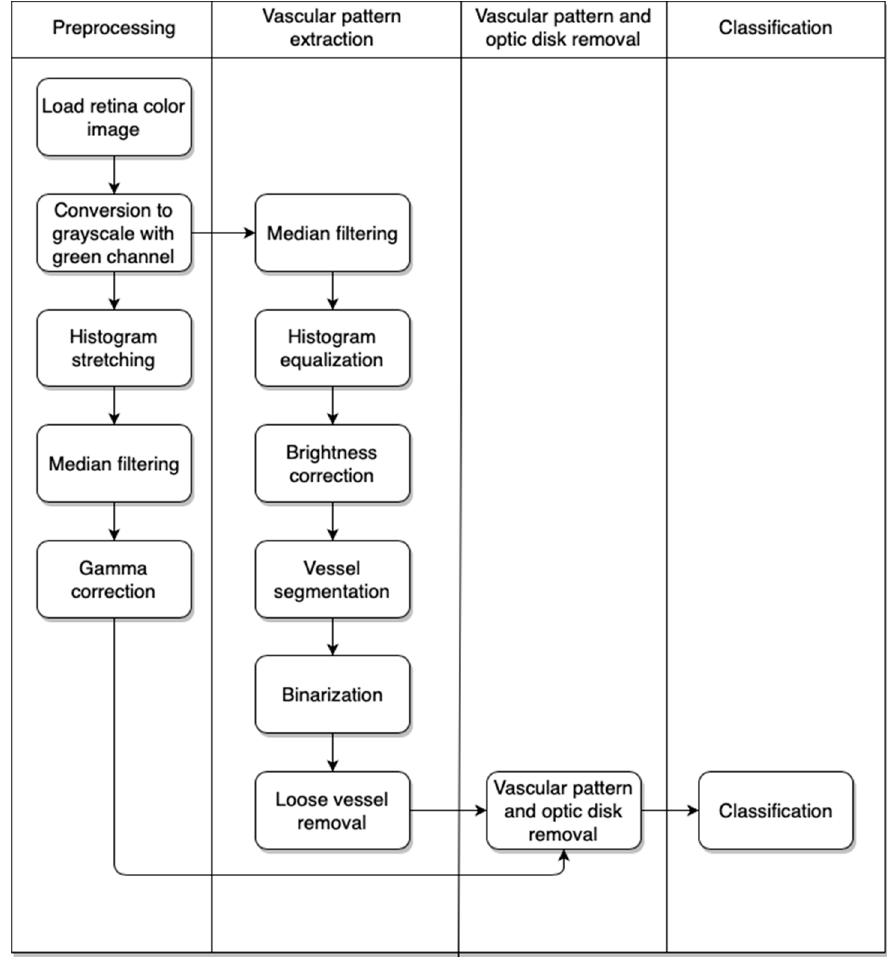
Figure 3. The activity diagram of the proposed approach.